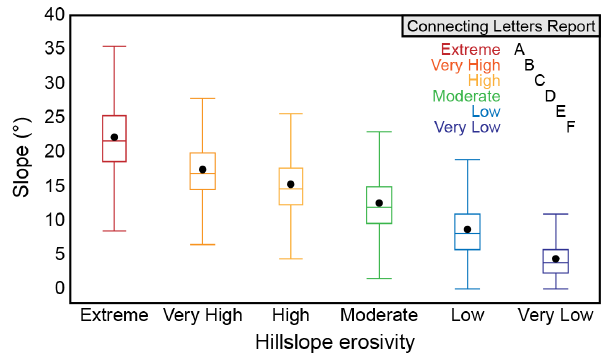
Figure 6. Analysis of variance, showing hillslope angles associated with categories of landscape erosivity (Kidd et al., 2014, 2015) at George River. Boxes and whiskers cover ± 1.5 × the interquartile range; black dots are the mean slope for the erosivity category. The mean slope for each erosivity category is significantly different from every other category, illustrated by the Connecting Letters Report (if the mean slope in any two erosivity categories were statistically indistinguishable, they would otherwise share a letter in the report). We therefore use hillslope angle as a quantitative proxy for erosivity in the George River